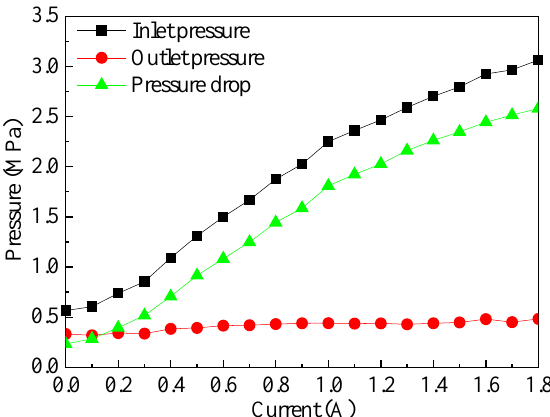
Figure 22. Experimental pressure of the optimal radial MR valve under different currents.